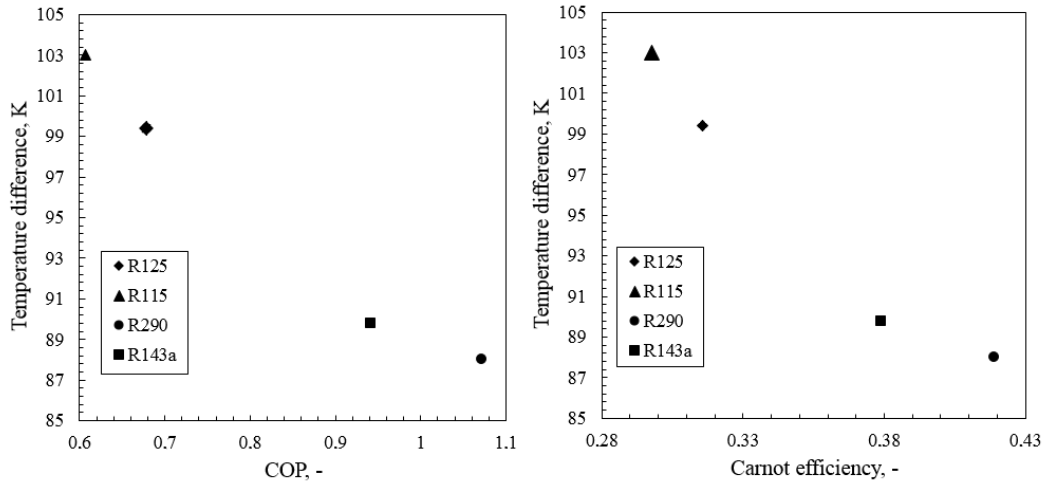
Figure 11. The performances of first stage